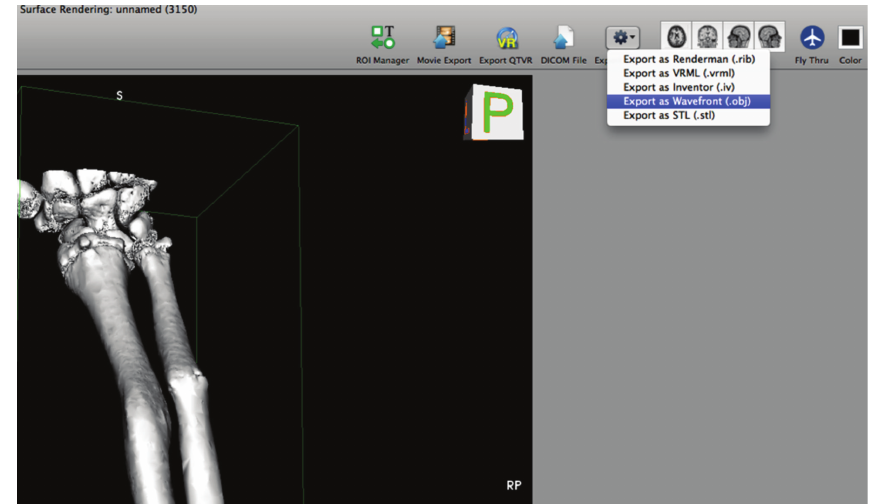
Figure 6: Exporting as an .obj